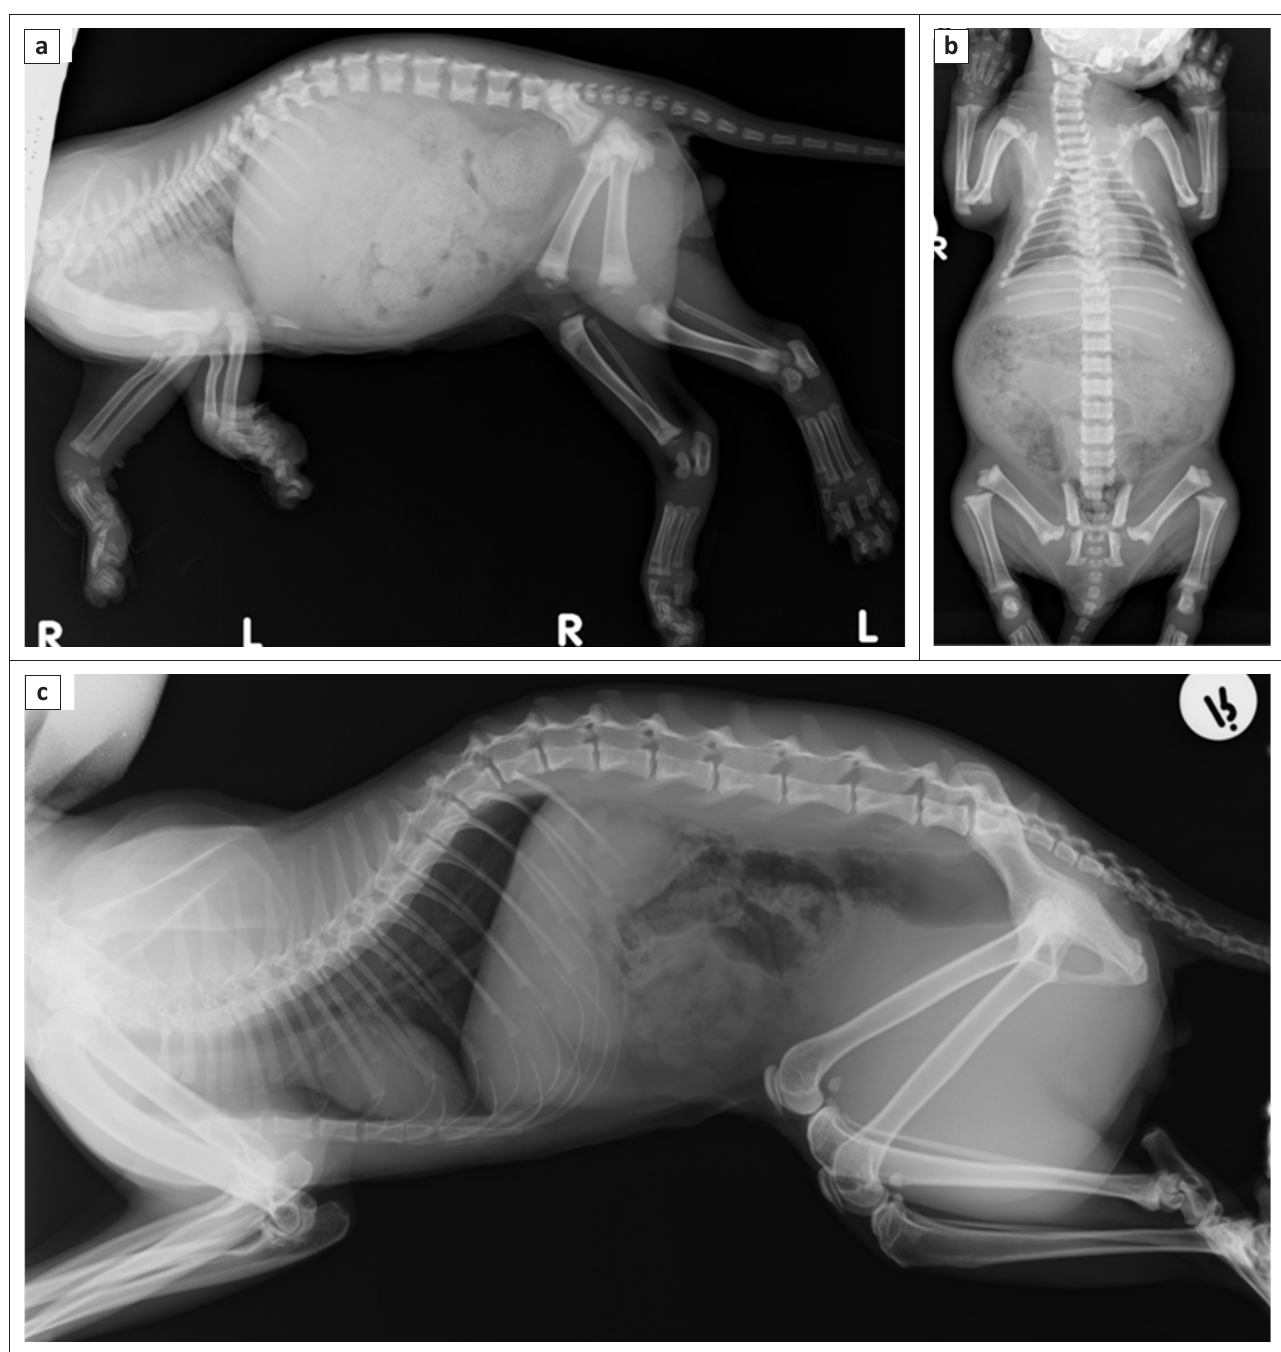
FIGURE 2: (a) Right lateral view and (b) dorsoventral view of the whole body of a 3-month-old kitten with primary congenital hypothyroidism, and (c) right lateral view of the whole body of the same cat at 26